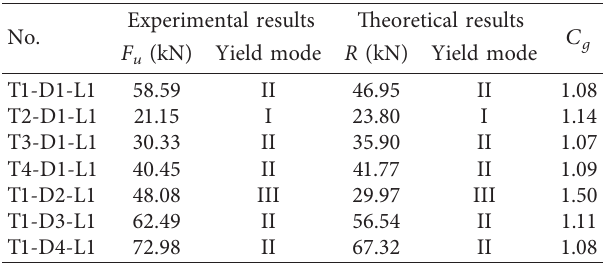
Table 3: The comparison of the load-carrying capacity of the connections.